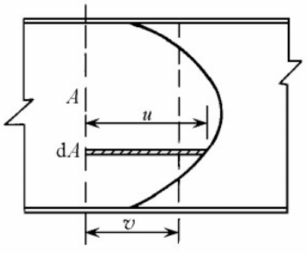
Figure 4. The average flow velocity of a flocking drainage pipe